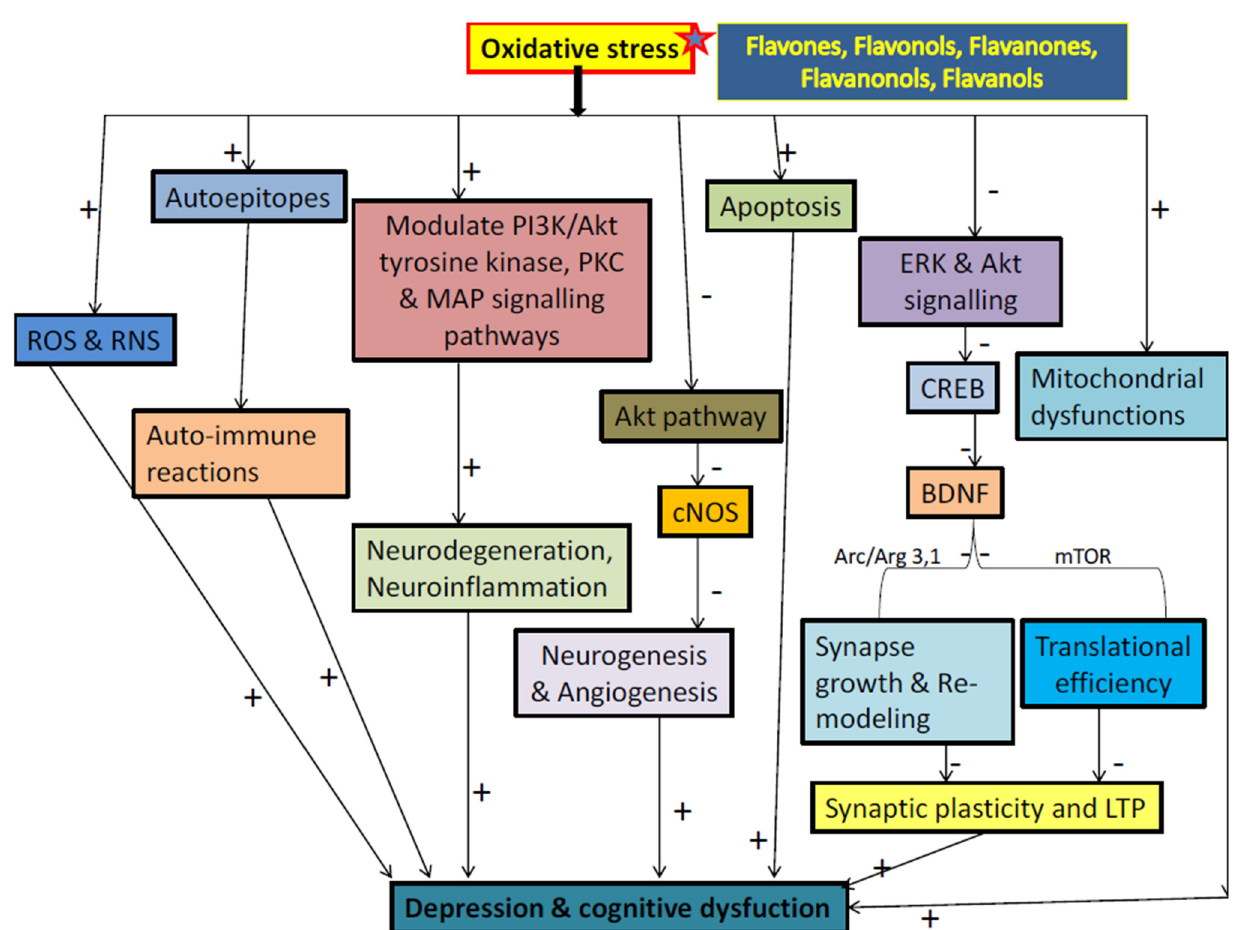
Figure 49. Possible antioxidant mechanism of flavonoids. ROS, reactive oxygen species; RNS, reactive nitrogen species; P13K, phosphoinositide 3-kinases; PKC, protein kinase C; MAP, mitogen-activated protein; cNOS, cyclic reactive oxygen species; ERK, extracellular regulated kinase; Akt (PKB), protein kinase B; BDNF, brain-derived neurotrophic factor; CREB, cAMP-response element binding protein; mTOR, mammalian target of rapamycin; Arc/Arg 3,1, Activity-regulated cytoskeletal-associated protein.